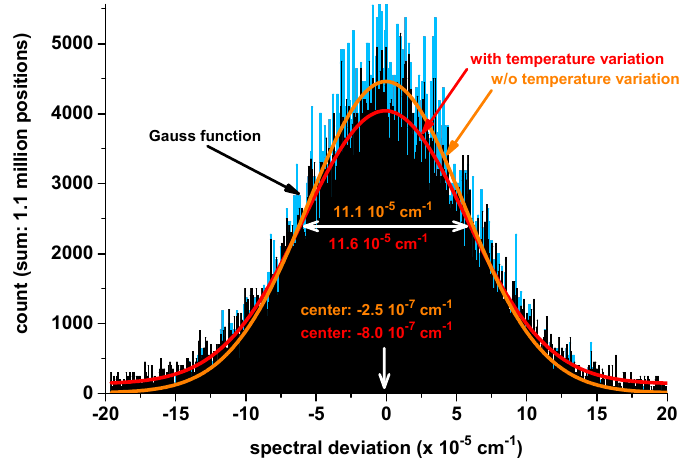
Figure 7. The black histogram shows the deviations between the actual and the set line position for the entire six day of validation. The blue histogram includes only the parts where the temperature of chamber and instrument were stable. The total number of line positions is scaled for comparison to the number of positions in the black histogram. The red Gaussian-shaped function corresponds to the black, the orange one to the blue histogram.